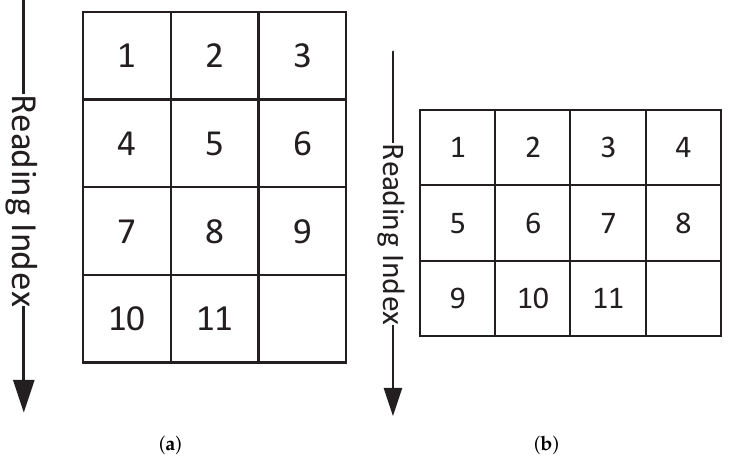
Figure 1. M mod z = z − 1 case: a 11 × 5 block. ( a ) p = 3, d min = 8; ( b ) p = 4, d min =